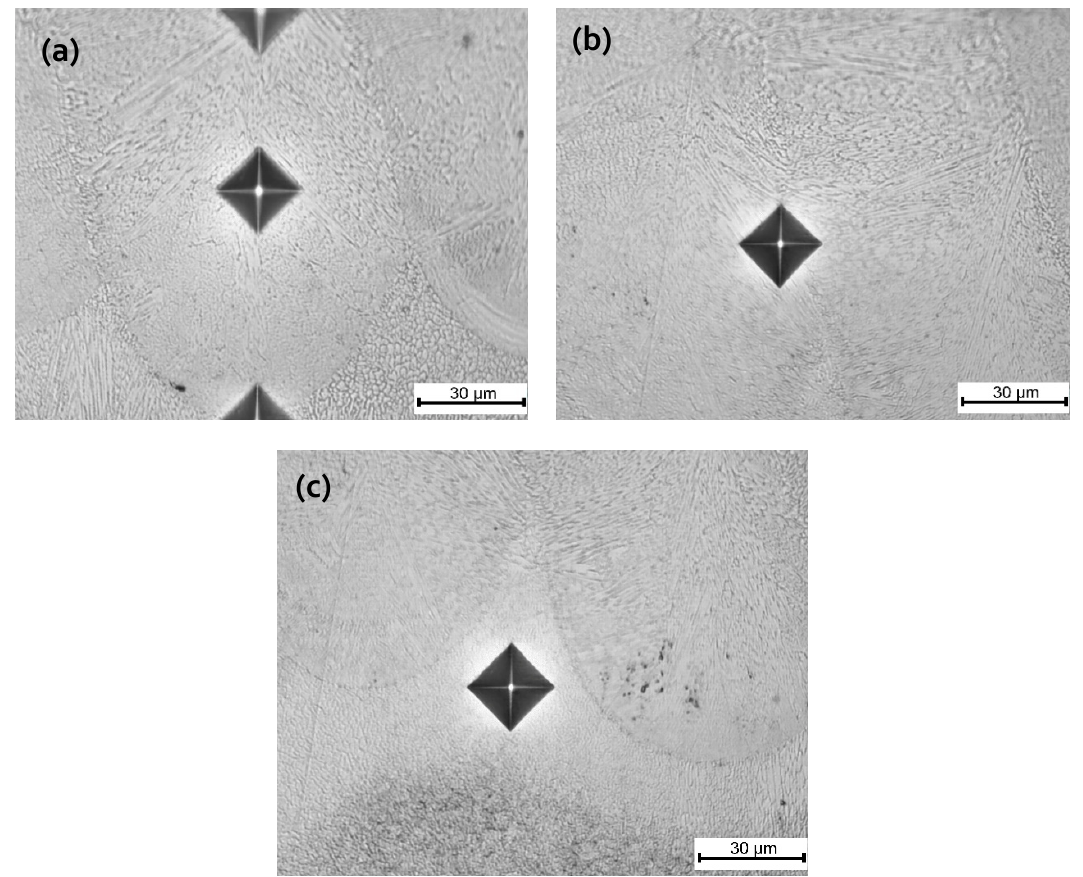
Figure 15. Vickers microhardness indentations in the topmost layer of PC9 sample along the build direction: ( a ) Along the melt-pool; ( b ) re-melted boundary; and ( c ) heat affected zone (HAZ).